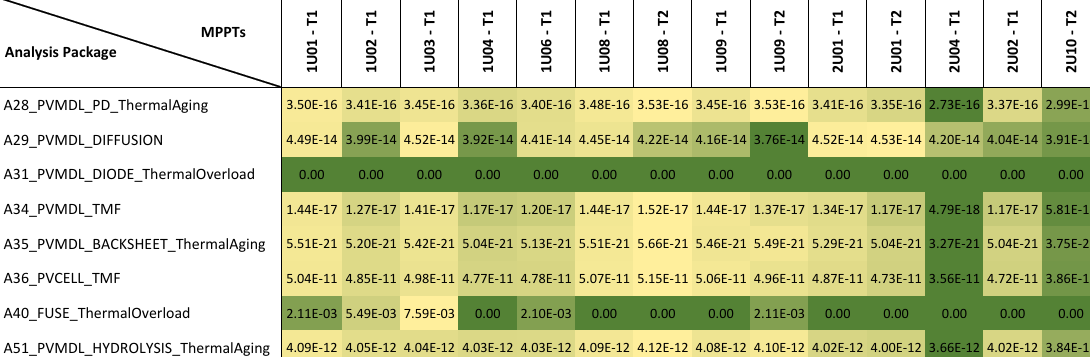
Figure 15. Damage calculation results for suspicious identified MPPTs.